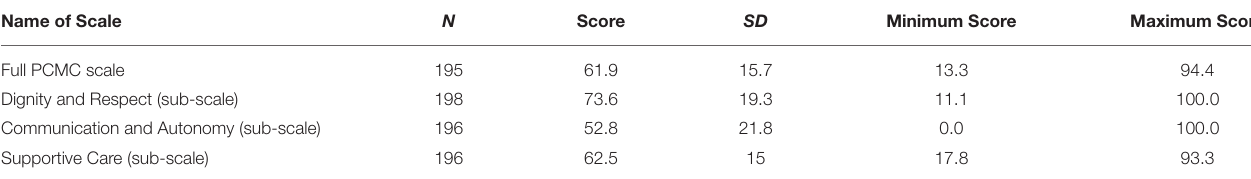
TABLE 2 | Distribution of Standardized Full PCMC and Sub-scale